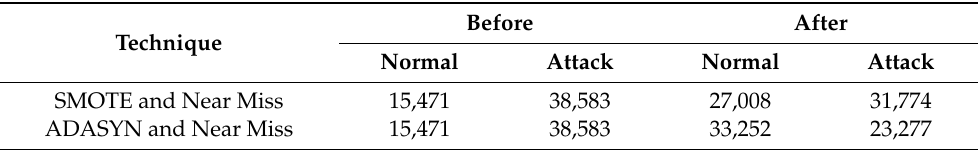
Table 11. Balancing Morris power dataset with hybrid sampling.